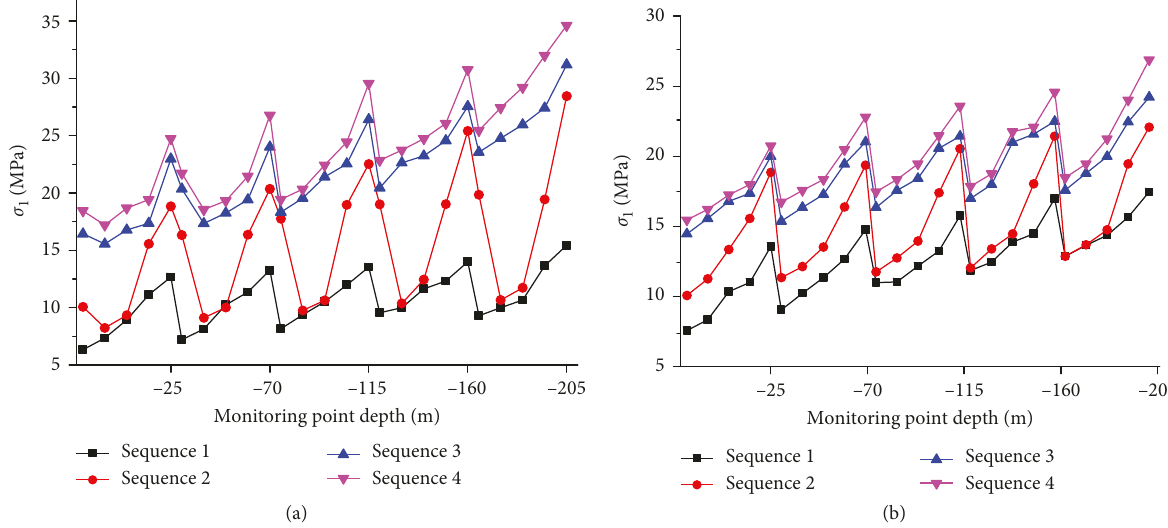
Figure 14: The maximum principal stress values evolution with depth. (a) Monitoring line 1. (b) Monitoring line 2.